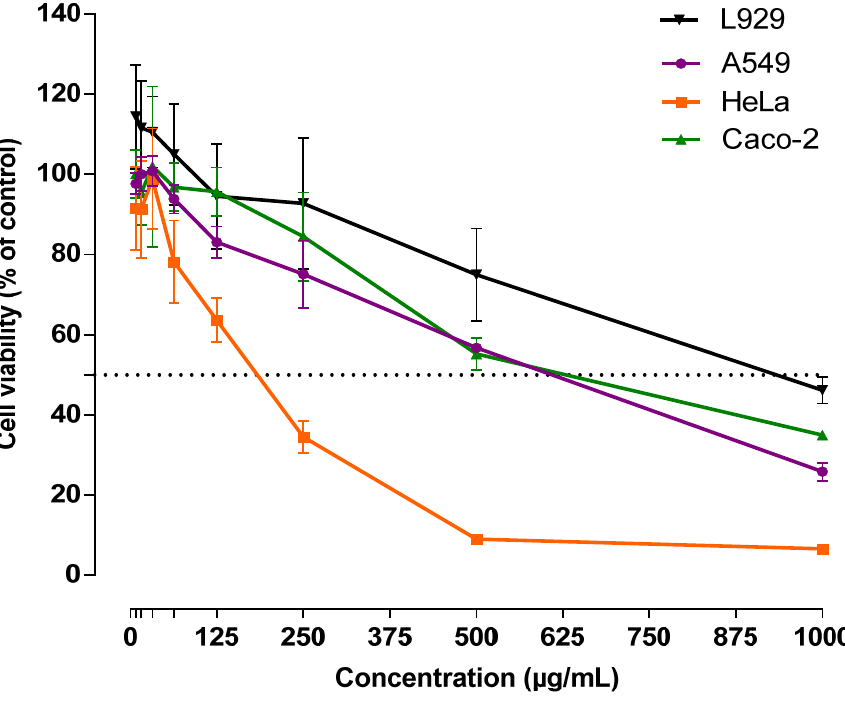
Figure 5. Cellular viability (%) of APE against normal mouse fibroblast (L929), human colorectal adenocarcinoma (Caco-2), human lung cancer (A549), and human cervix epithelioid carcinoma (HeLa).